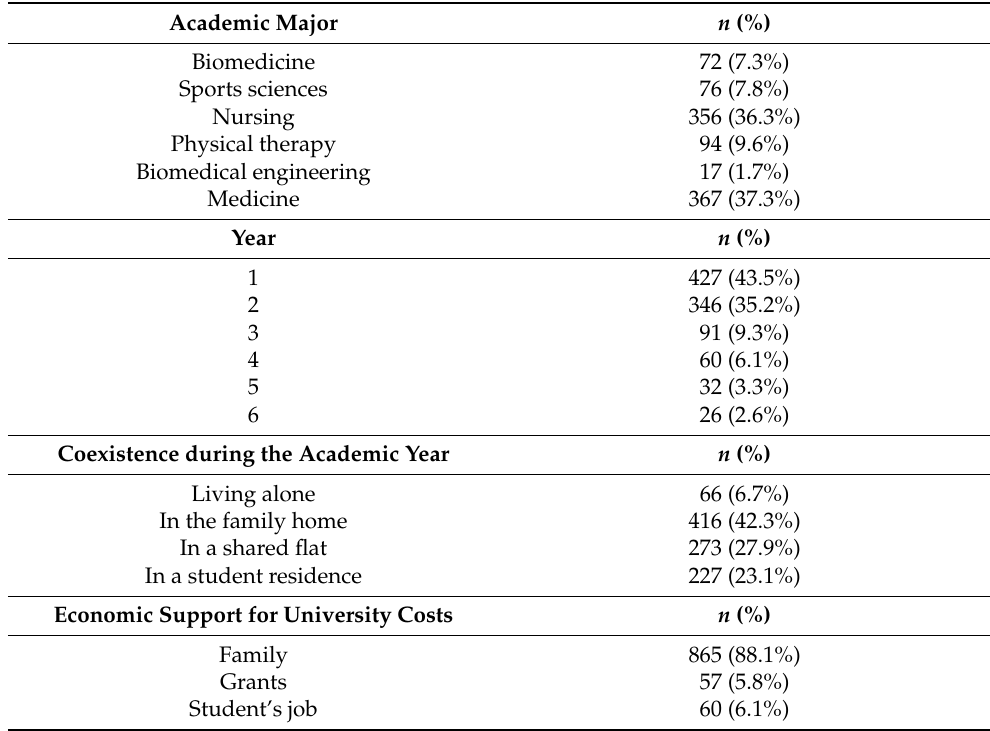
Table 1. Academic and socioeconomic characteristics among the participants ( n =